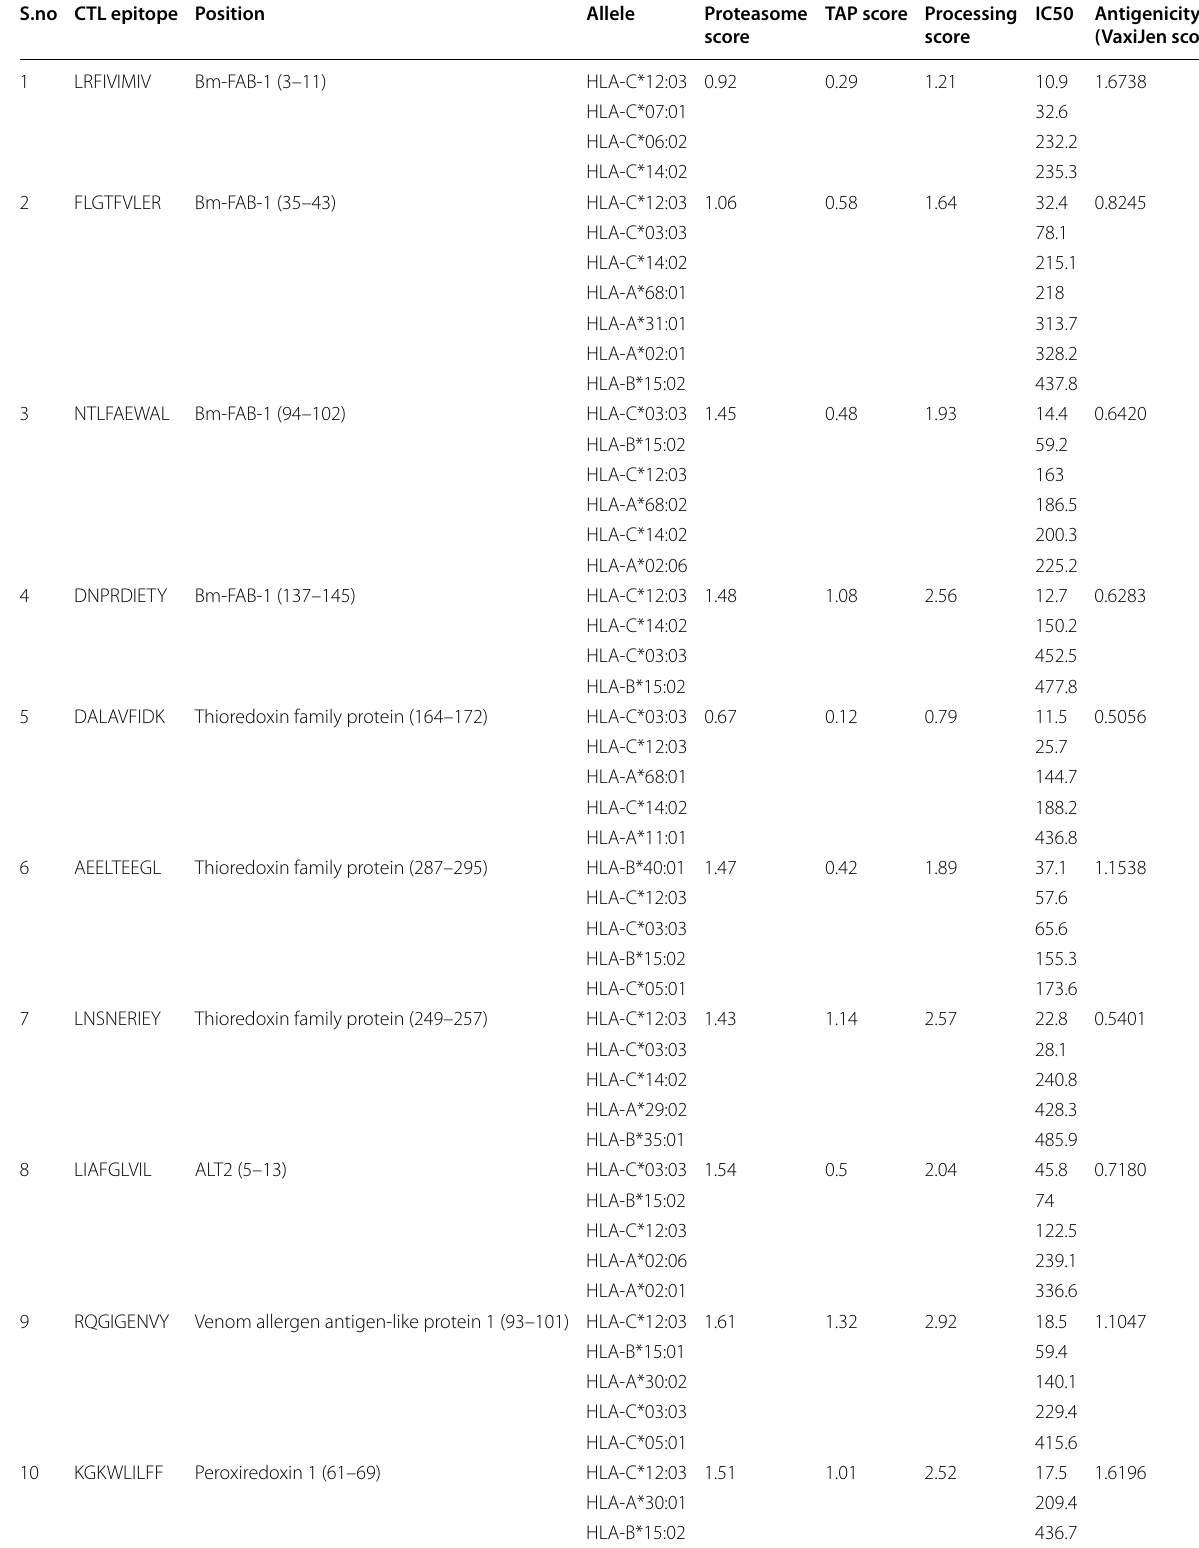
Table 3 T epitopes with its binding allele (IC50 < 500 nM) C S.no CTL epitope